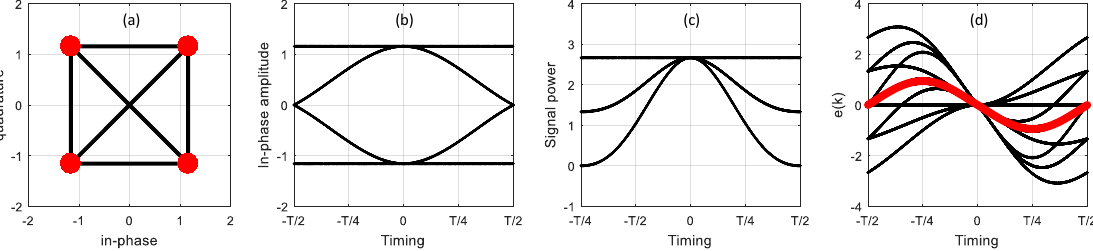
Figure 2. ( a ) QPSK constellation, in red, with its intersymbol transitions, in black; ( b ) In-phase component eye-diagram; ( c ) Power eye-diagram; ( d ) S-curve, in red, and all values e Gardner can assume in a QPSK signal, in